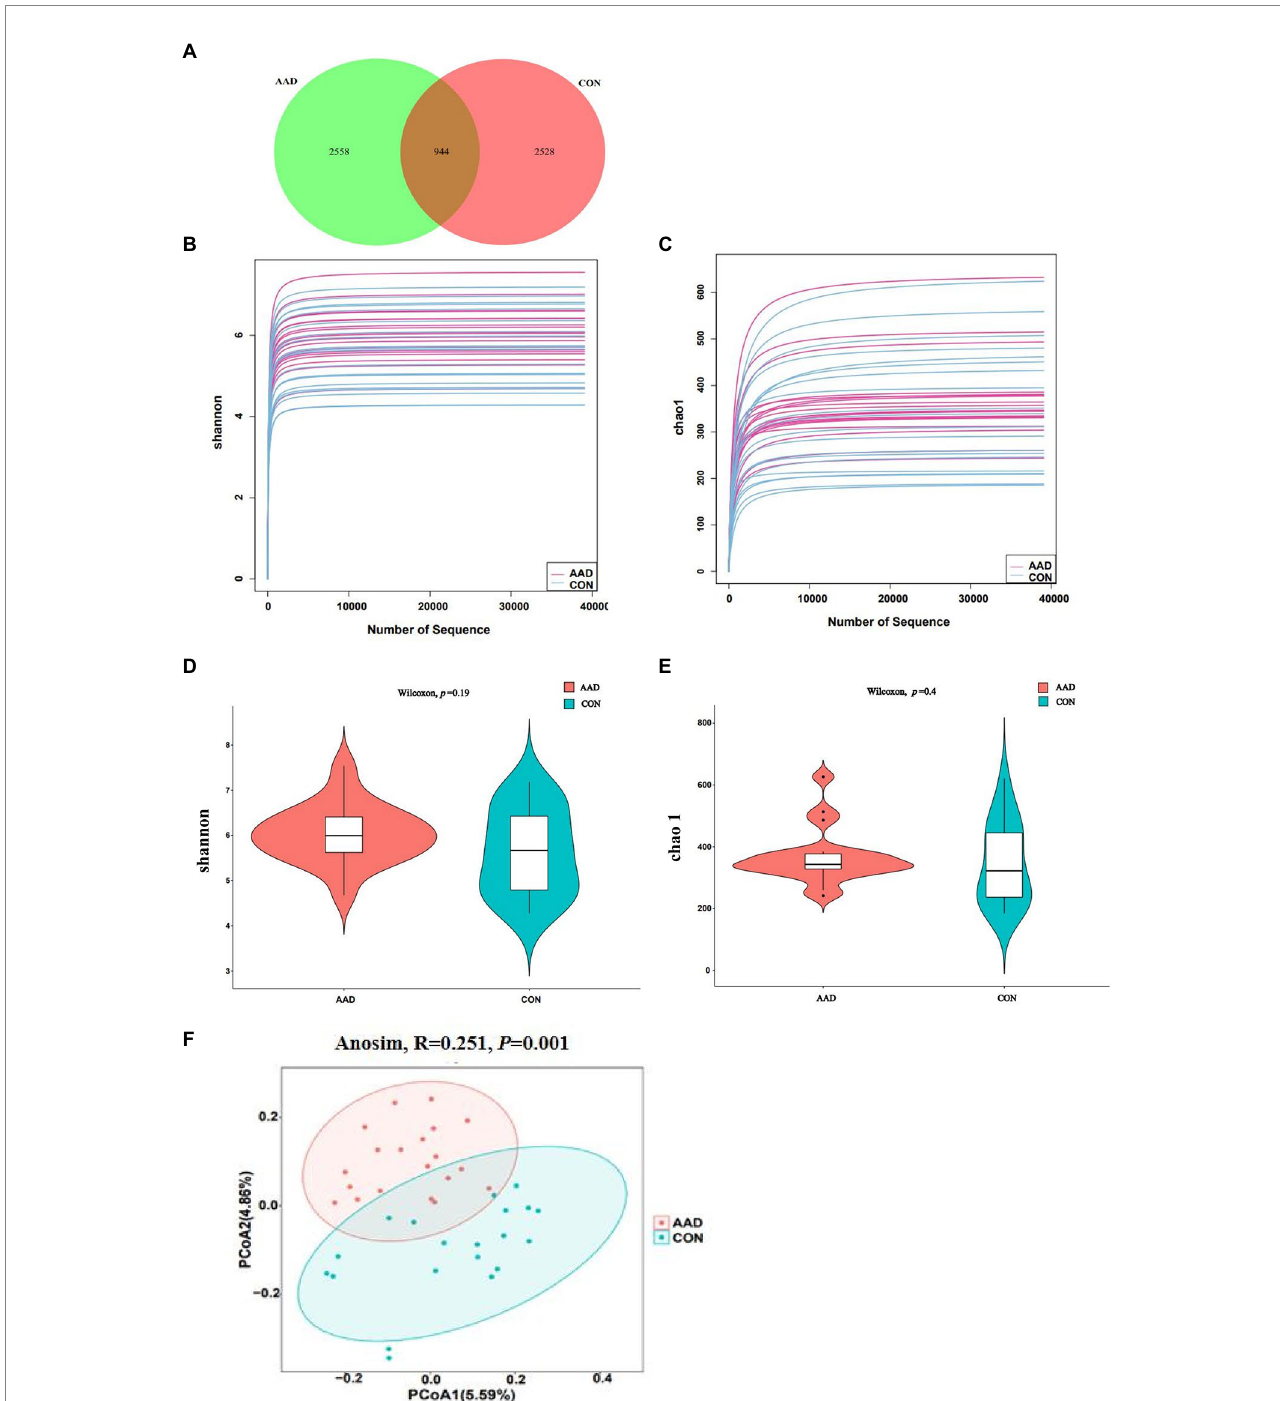
FIGURE 1 Diversity of the gut microbiota in patients with AAD and healthy controls. (A) Venn diagram showing the number of unique and common ASVs between the two groups. (B,C) Rarefaction curves of Shannon index and Chao 1. (D,E) Comparisons of Alpha diversity as determined by Shannon index and Chao 1 between the AAD and control groups. (F) Comparisons of Beta diversity as determined by Jaccard distance between the AAD and control groups. ASVs, amplicon sequence variants; PCoA, principal coordinate analysis; Anosim, analysis of similarities, N =